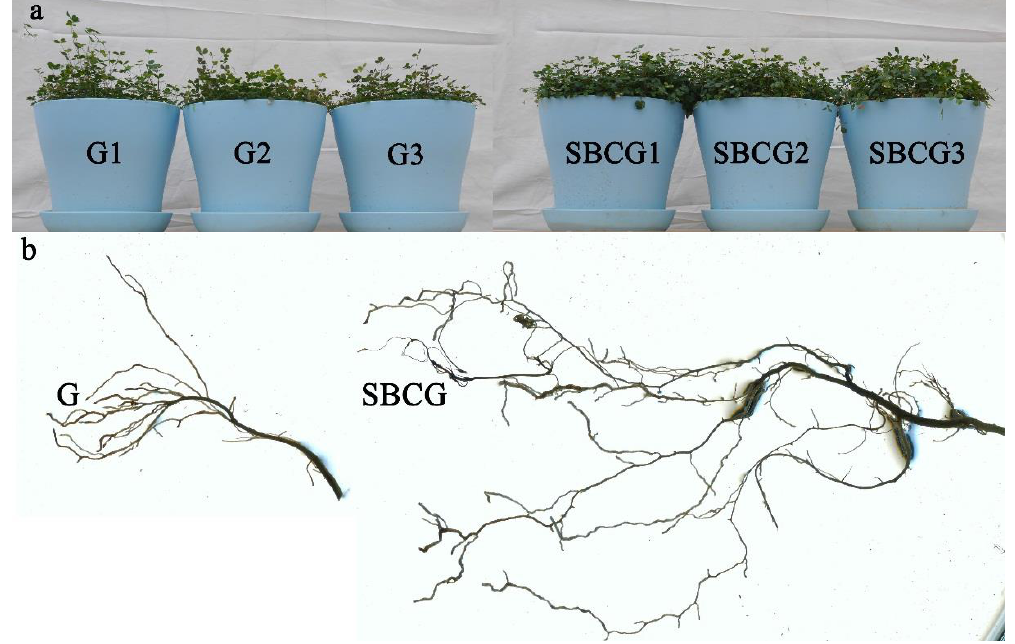
Figure 8. Alfalfa growth ( a ) and root morphology ( b ) in the alfalfa revegetation (G) and combined alfalfa and sludge biochar amendment (SBCG) treatments. Table 5. The plant height, root length, shoot biomass, root biomass, and total biomass of alfalfa after incubation (mean ± S.V. (standard deviation), n = 3).